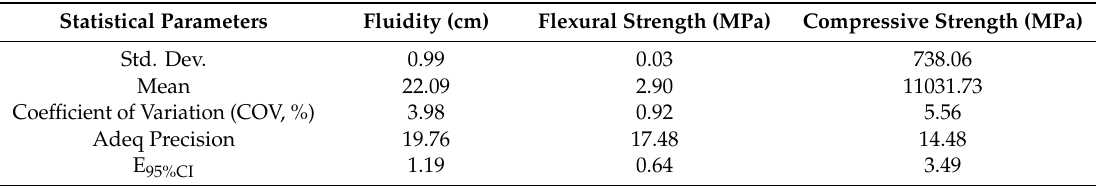
Table 8. Statistical analysis of the experimental